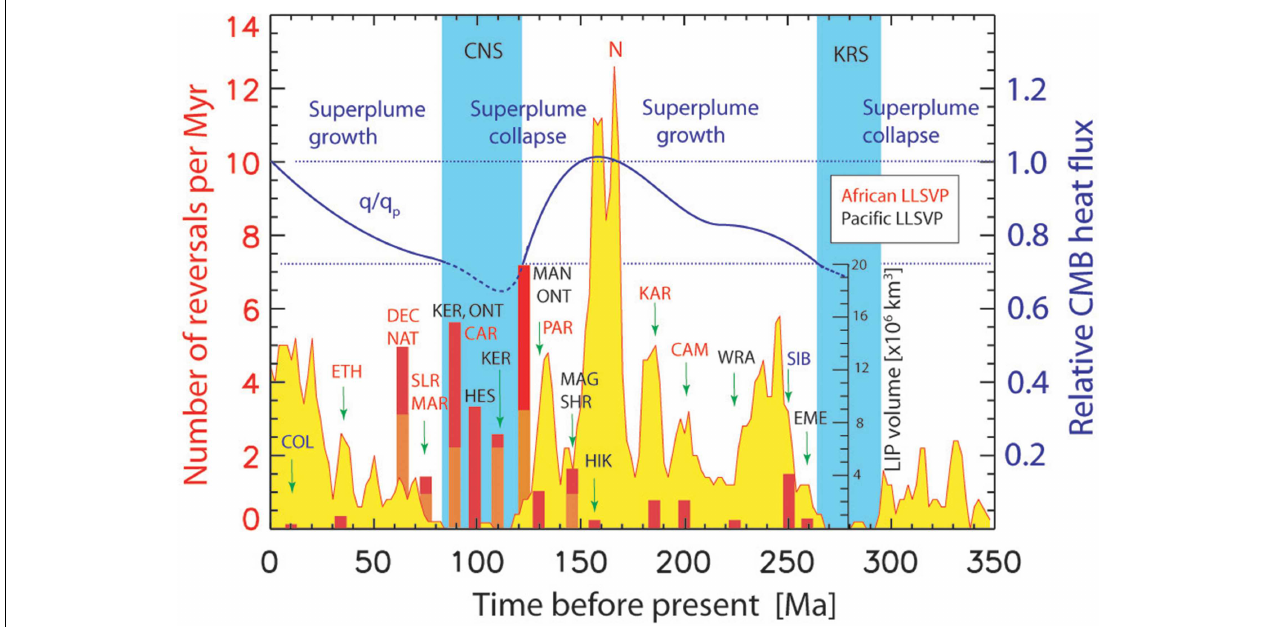
FIGURE 4 | Composite showing the relationships between time variations in geomagnetic polarity reversal frequency, formation of major large igneous provinces (LIPs), inferred CMB heat flux variations, and inferred variations in lower mantle superplumes. Polarity reversal frequency N with 5 Myr running average is from the 2012 GPTS (Gradstein et al., 2012), CMB heat flux q is relative to present-day q p , both from Figure 3 . LIPs associated with the African/Pacific large low shear velocity provinces (LLSVPs) are labeled in red/black, respectively; blue